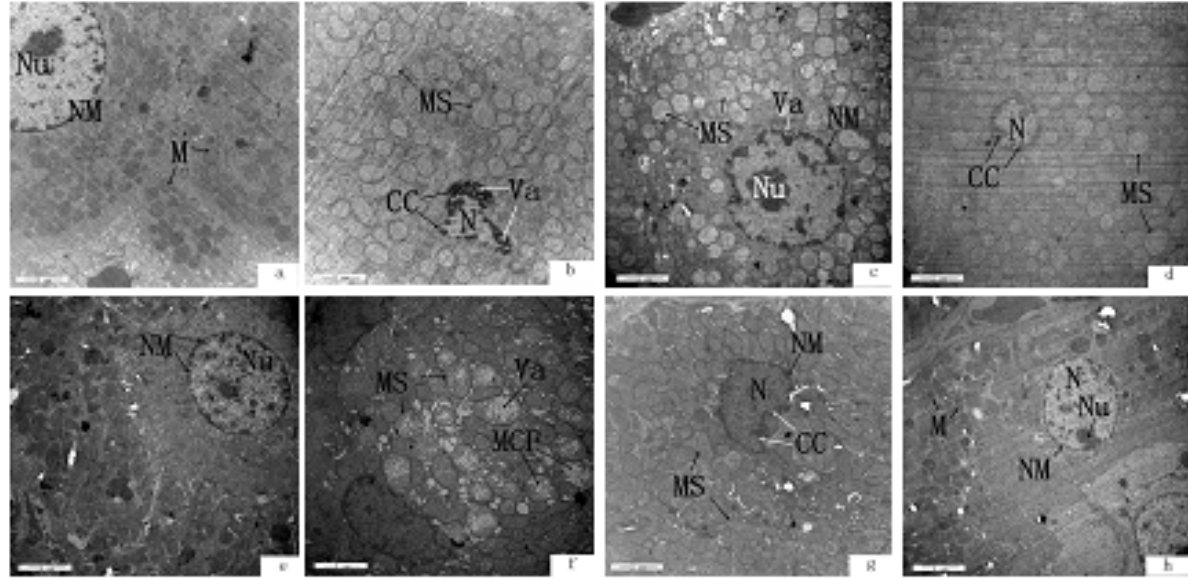
Figure 1. The ultrastructure of the liver and kidney tissues in rats. ( a ) liver of control rat; ( b ) liver of rat exposed to 100 mg/L fluoride; ( c ) liver of rat of exposed to 100 mg/L fluoride plus 5 g/kg MPPP; ( d ) liver of rat exposed to 100 mg/L fluoride plus 10 g/kg MPPP; ( e ) kidney of control rat; ( f ) kidney of rat exposed to 100 mg/L fluoride; ( g ) kidney of rat of exposed to 100 mg/L fluoride plus 5 g/kg MPPP; ( h ) kidney of rat exposed to 100 mg/L fluoride plus 10 g/kg